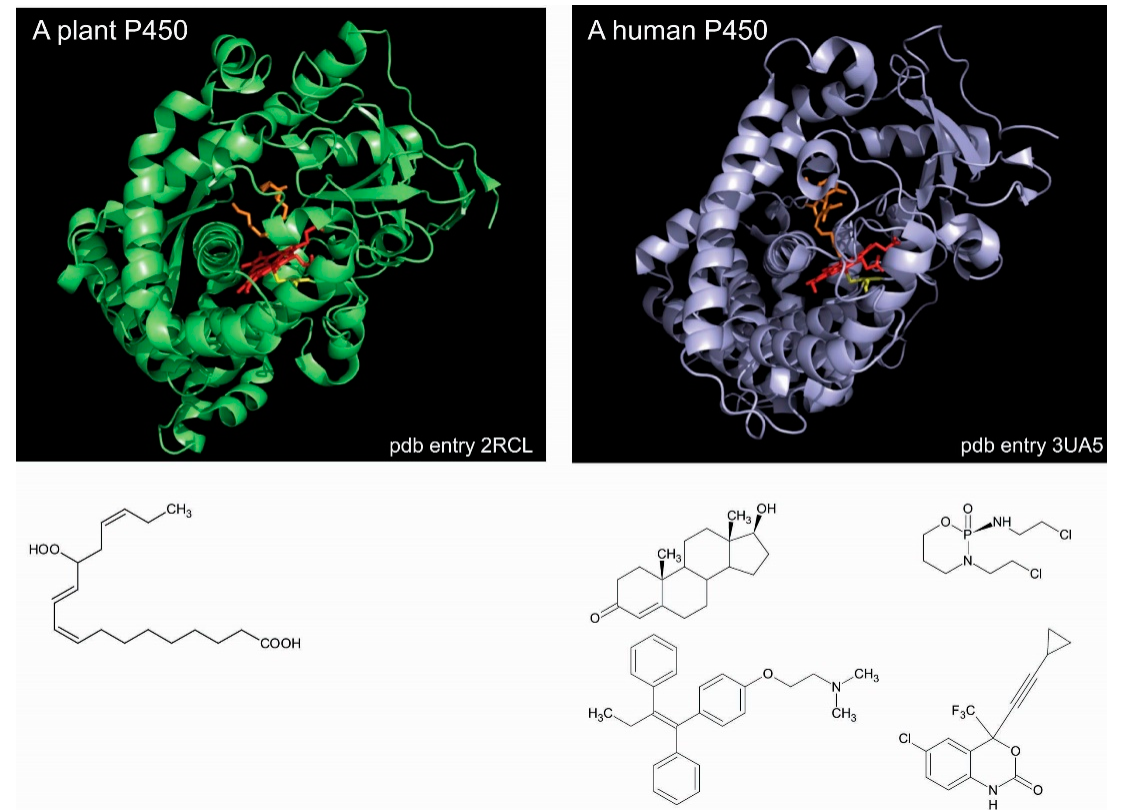
Figure 1. P450 enzymes exhibit similar structures. Left panel, CYP74A from Arabidospsis thaliana complexed by 12R,13S-vernolic acid at 2.4 Å resolution (pdb entry 3dam) [16]. Right panel, human CYP2B6 complexed by amlodipine at 2.24 Å resolution (pdb entry 4zv8) [17]. The amino acid sequence identity between the two proteins is 14%. The heme is represented in both enzymes as red sticks and the bound ligand as orange sticks. The heme-liganding cysteine is colored yellow. Protein visualizations were performed by using PyMol (Delano Scientific LLC, San Carlos, CA, USA). The caption under both of the crystal structures represents the single CYP74A substrate (allene oxide) on the left and some of many CYP2B substrates on right.